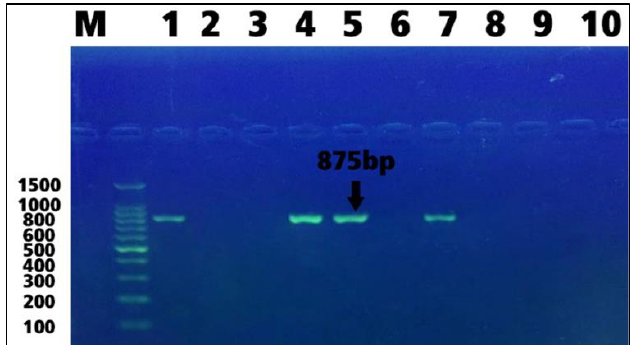
Figure 1. Agarose gel (2%) electrophoresis with SYBR Safe stain shows amplification of 875 bp fragment of ama-1 gene. PCR product was emigrated at 5 volt/cm 2 , for one and half h and visualized under UV light. Lane M: DNA ladder (100 bp); Lanes 1, 4, 5, and 7 positive cases